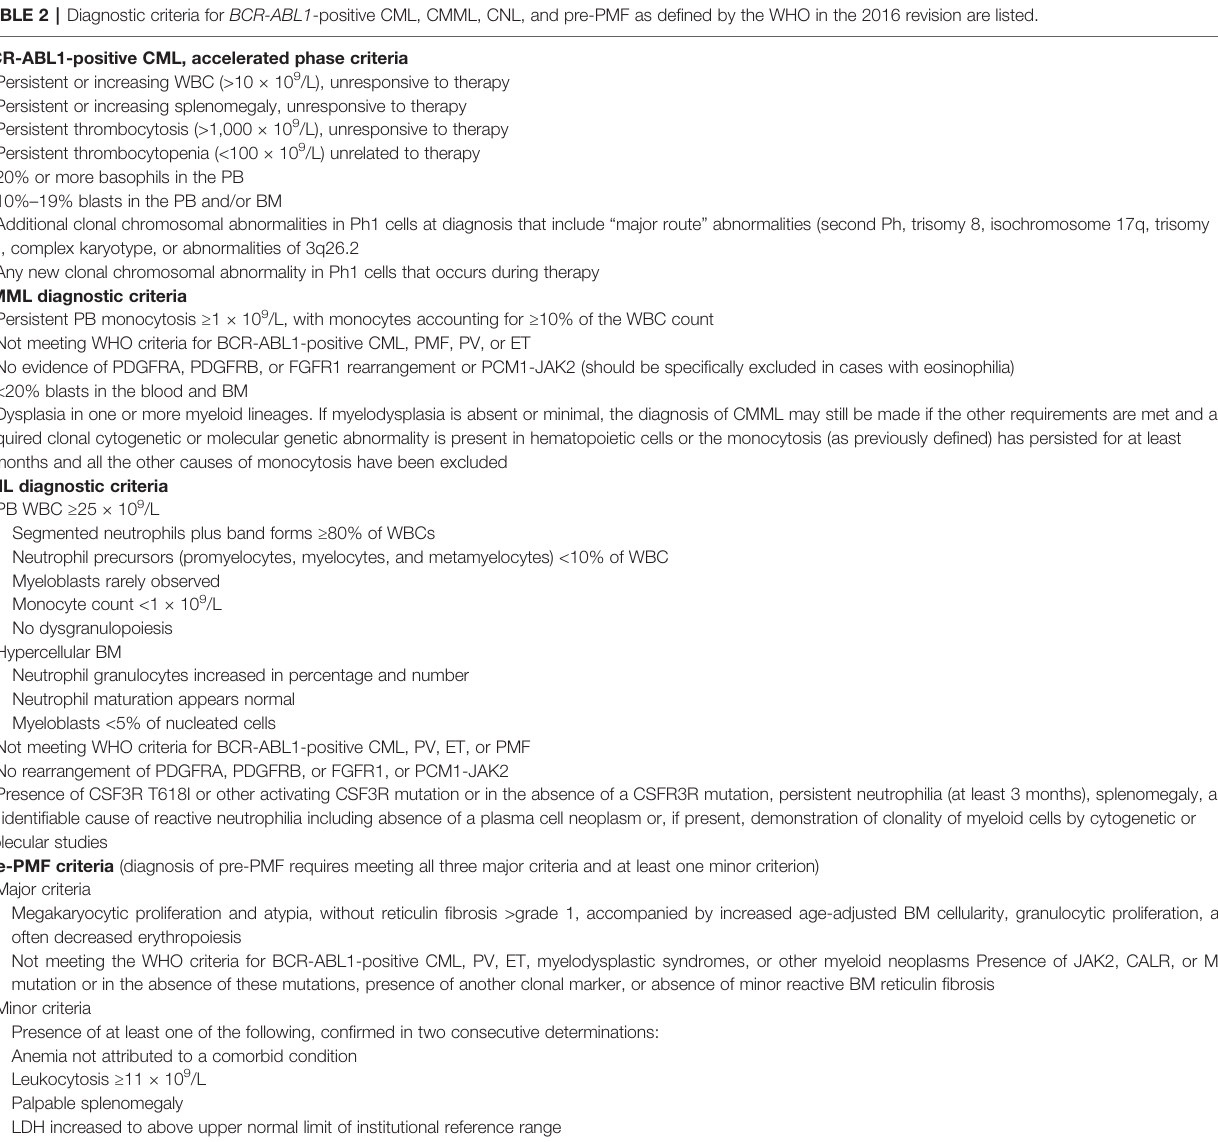
TABLE 2 | Diagnostic criteria for BCR-ABL1 -positive CML, CMML, CNL, and pre-PMF as de fi ned by the WHO in the 2016 revision are listed. BCR-ABL1-positive CML, accelerated phase criteria Persistent or increasing WBC (>10 × 10 9 /L), unresponsive to therapy Persistent or increasing splenomegaly, unresponsive to therapy Persistent thrombocytosis (>1,000 × 10 9 /L), unresponsive to therapy Persistent thrombocytopenia (<100 × 10 9 /L) unrelated to therapy 20% or more basophils in the PB 10% – 19% blasts in the PB and/or BM Additional clonal chromosomal abnormalities in Ph1 cells at diagnosis that include “ major route ” abnormalities (second Ph, trisomy 8, isochromosome 17q, trisomy 19), complex karyotype, or abnormalities of 3q26.2 Any new clonal chromosomal abnormality in Ph1 cells that occurs during therapy CMML diagnostic criteria Persistent PB monocytosis ≥ 1 × 10 9 /L, with monocytes accounting for ≥ 10% of the WBC count Not meeting WHO criteria for BCR-ABL1-positive CML, PMF, PV, or ET No evidence of PDGFRA, PDGFRB, or FGFR1 rearrangement or PCM1-JAK2 (should be speci fi cally excluded in cases with